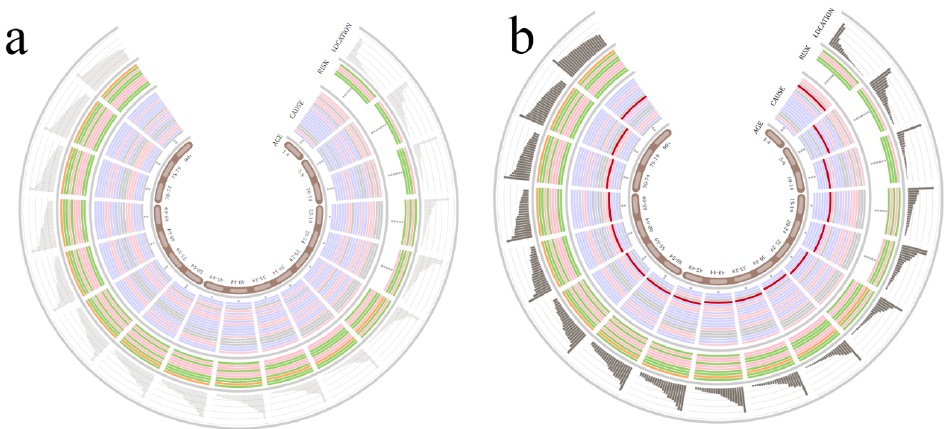
Figure 4. ( a ) Risk track emphasized while location and cause tracks de-emphasized; ( b ) nutritional deficiencies cluster emphasized in the cause track.